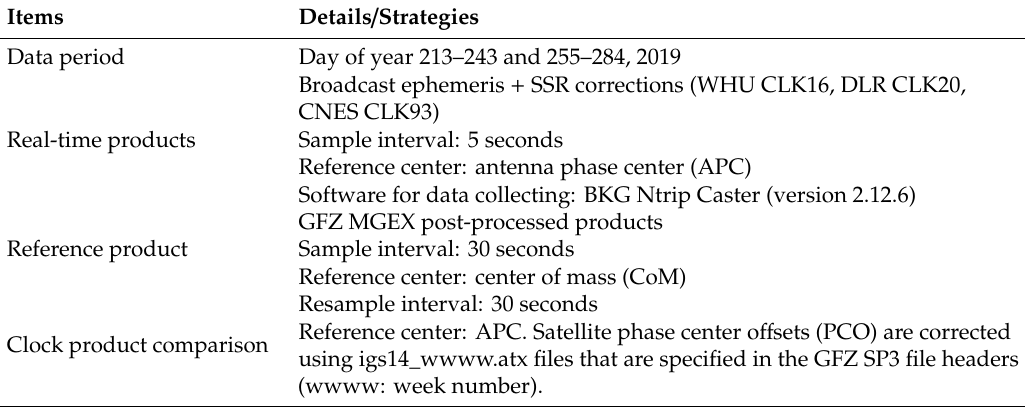
Table 1. Data details and processing strategies.